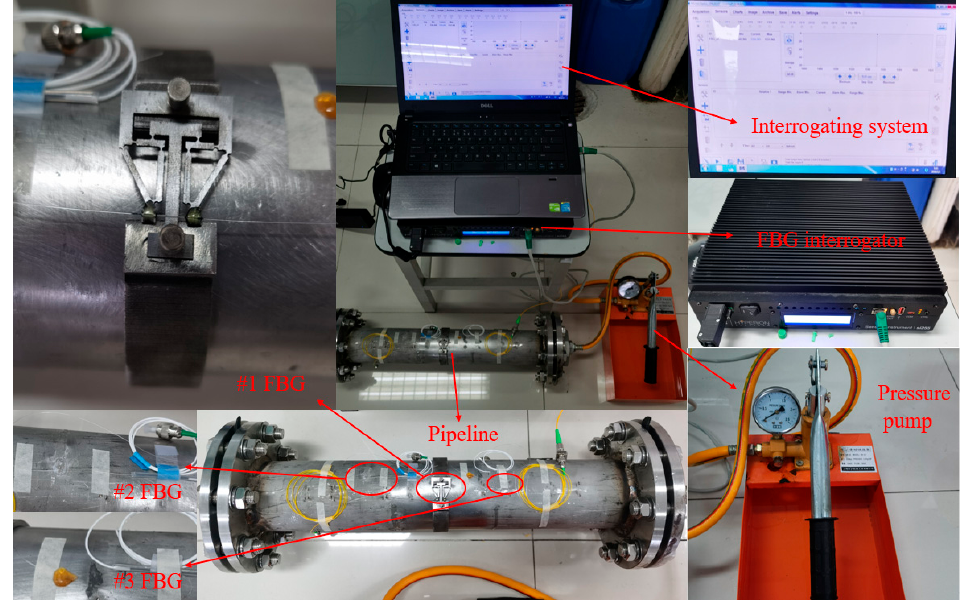
Figure 13. Experimental system set up. Table 4. Experimental data and relative errors.